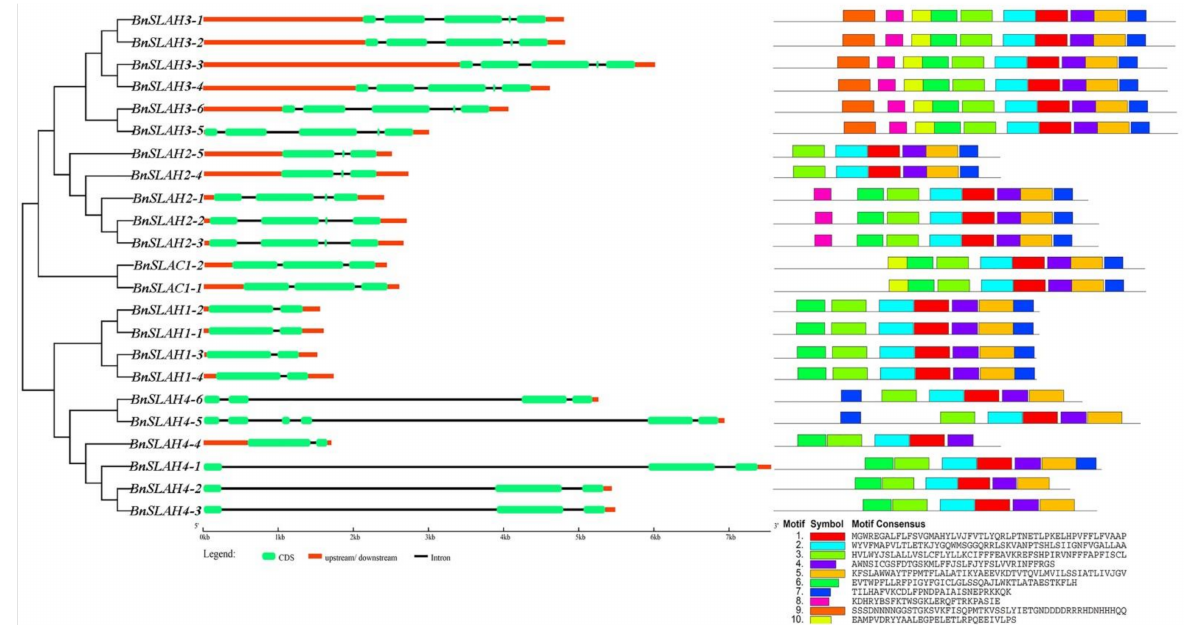
Figure 3. The phylogenetic relationships, gene structures and conserved motifs of SLAC/SLAHs in B. napus